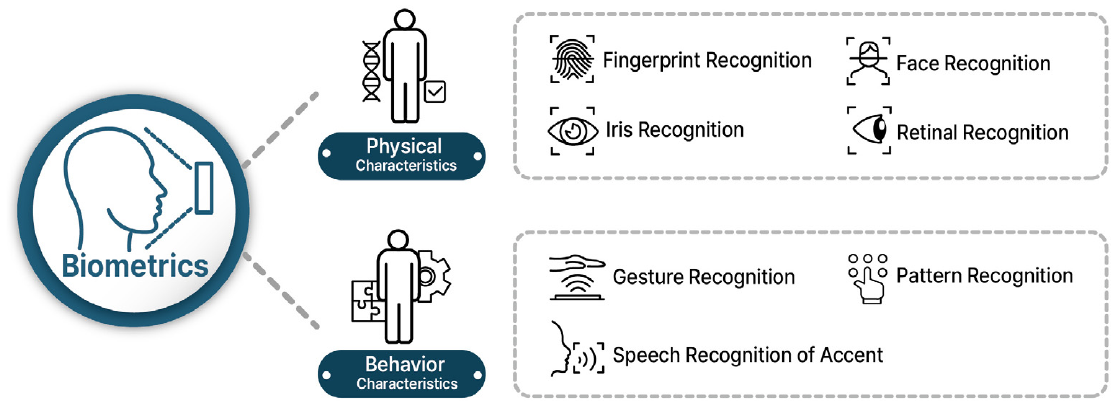
Figure 2. Features of Biometrics.